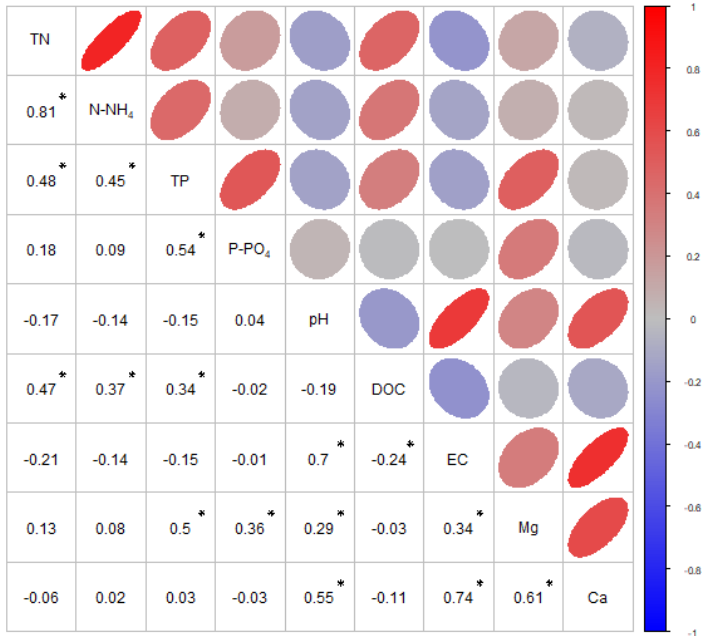
Figure 7. Correlation matrix for the selected parameters preselected by the Kruskal–Wallis tests. The lower triangular part of the matrix contains Pearson correlation coefficients for each pair of variables specified on the diagonal. Correlation coefficients significantly different from 0 for p < 0.05 are marked with an asterisk (*). The upper triangular part of the matrix contains the visualisation of correlation coefficients in the form of ellipses. The ellipse represents a level curve of the density of a bivariate normal with the matching correlation.